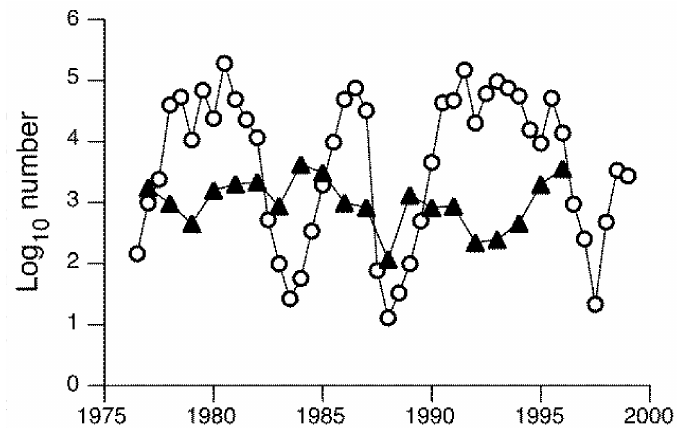
Figure 2. Window trap catches of adult chironomids, Tanytarsus gracilentus and Orthocladius oblidens , at Lake M ý vatn, Iceland (trap site SN) between the years 1976 and 2000. T. gracilentus (open circles) is bivoltine with two, non-overlapping generations per year; O. oblidens (closed triangles) is univoltine. Redrawn from